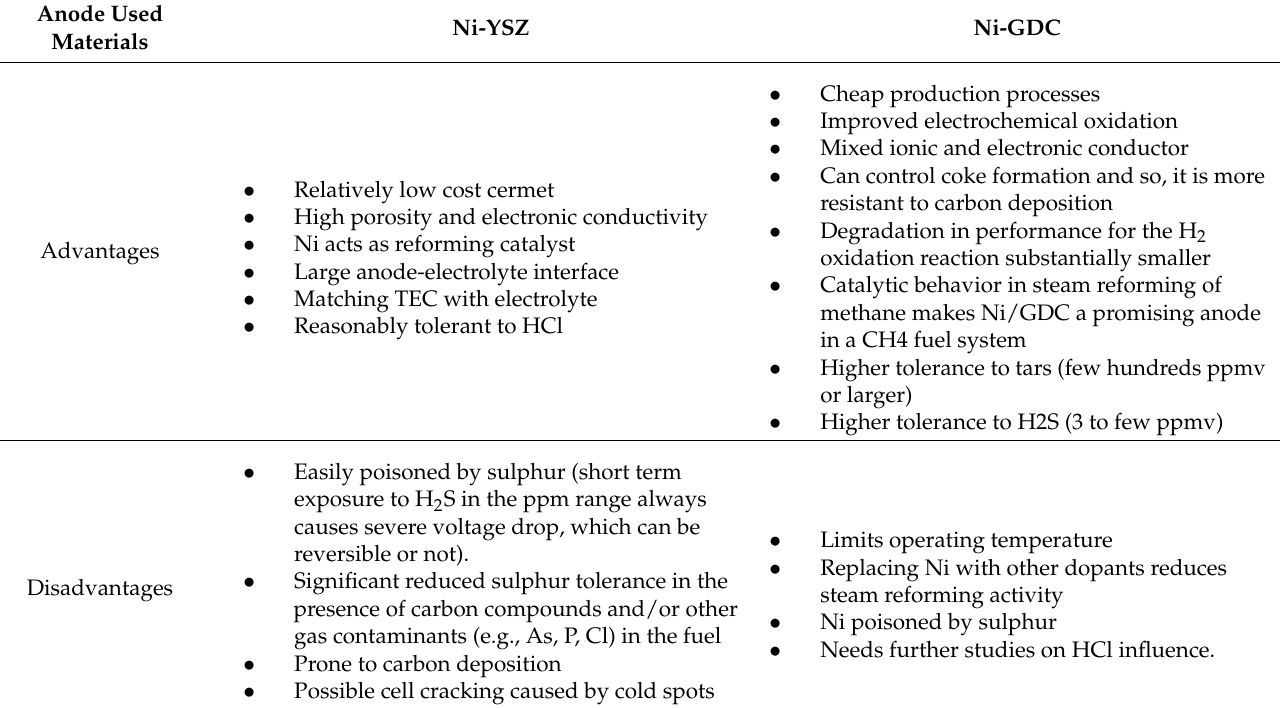
Table 7. Comparison between the Ni-YSZ and Ni-GDC anode [2,78,80]. Anode Used